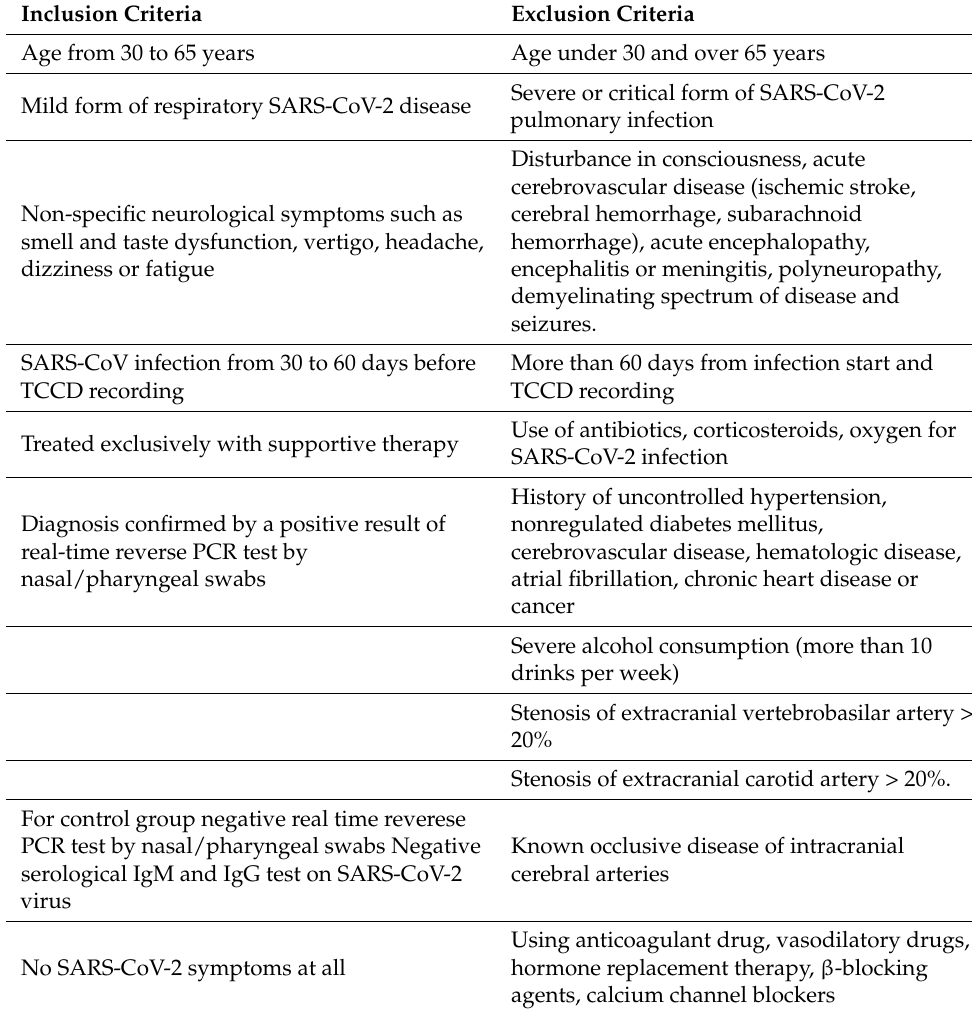
Table 1. Inclusion and exclusion